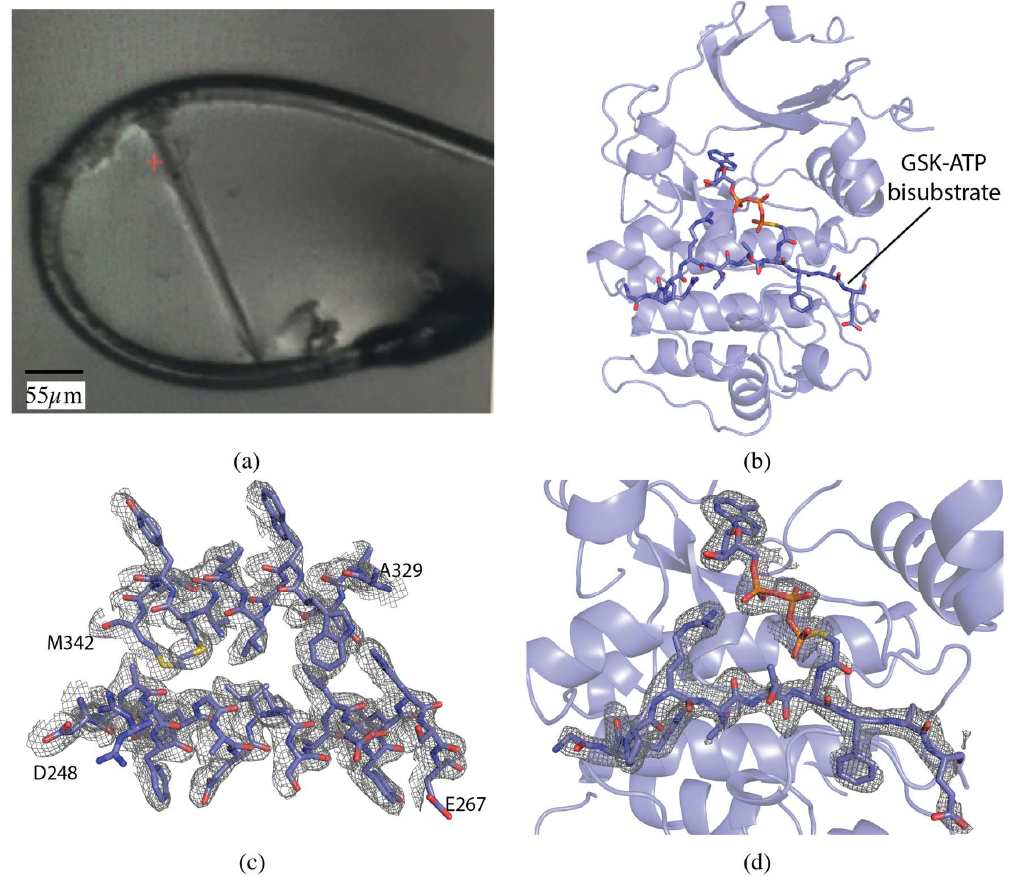
Figure 1. Vector data collection of Akt1 crystals. ( a ) Akt1 crystal in loop. ( b ) Akt1 structure (PDB ID 6NPZ). Ribbon representation of Akt1, with the GSK3-ATP bisubstrate analog shown in stick representation. ( c ) 2mFo-DFc map for a section of Akt1 contoured at 1.0 σ . ( d ) mFo-DFc omit map for GSK3-ATP bisubstrate analog contoured at 3.0 σ.